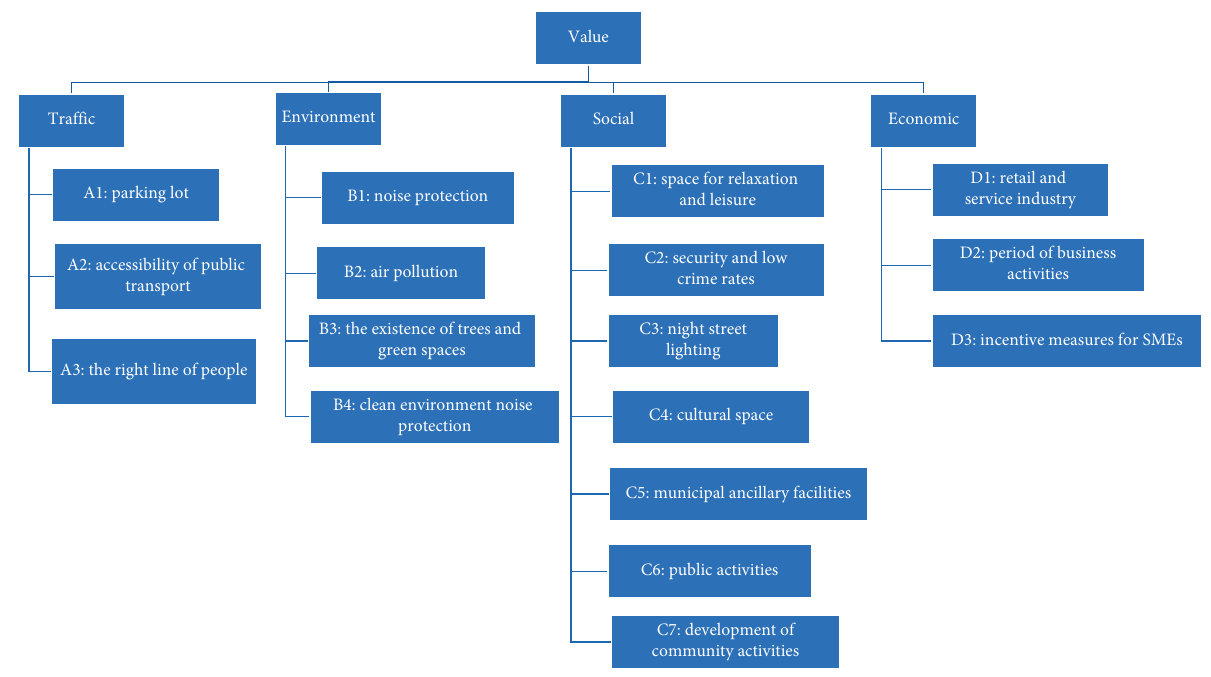
Figure 13: Evaluation system.